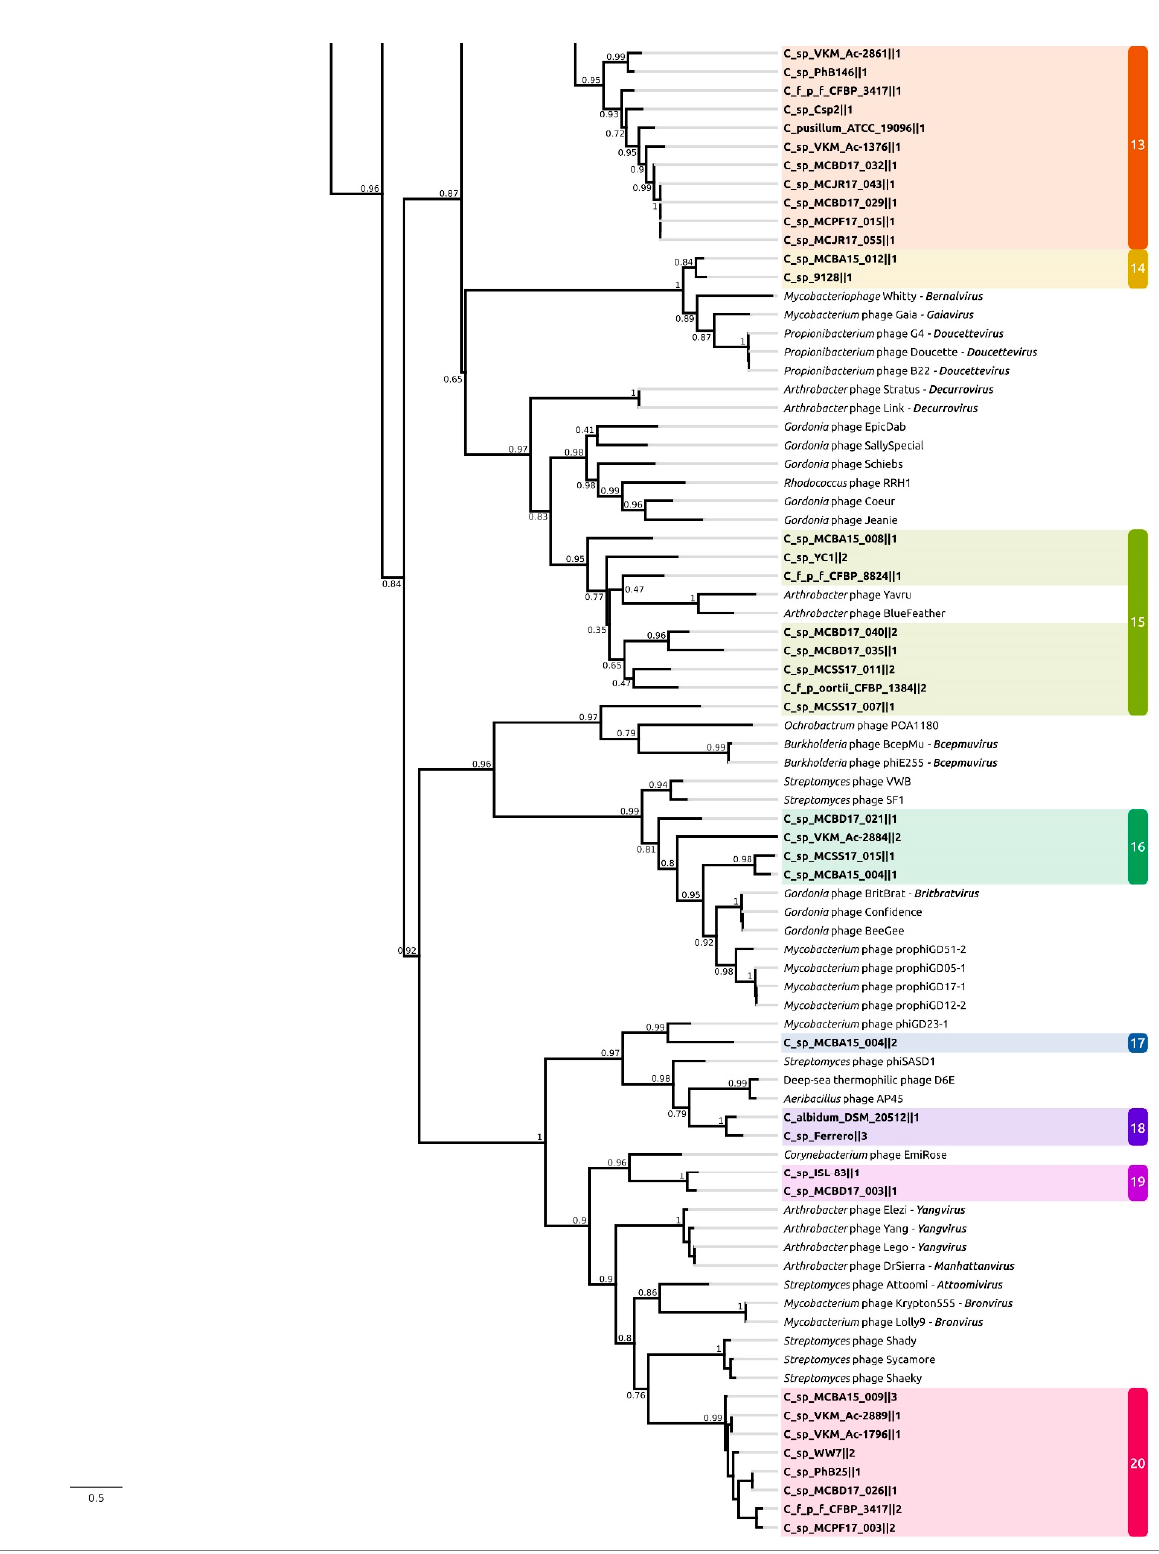
Figure 4. Best-scoring ML phylogenetic tree constructed with 164 amino acid sequences of major capsid protein. The NCBI taxonomy is shown to the right of the phage name. The numbers near the tree branches indicate the TBE values. The total number of bootstrap trees was 1000. The scale bar shows 0.5 estimated substitutions per site and the tree was rooted to C_sp_C1 (cid:107) 1. Different background colours and numbers indicate the clustering proposed for